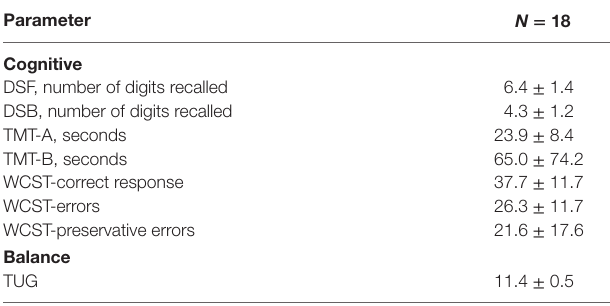
TaBle 2 | Cognitive, affect, and balance measures of participants.